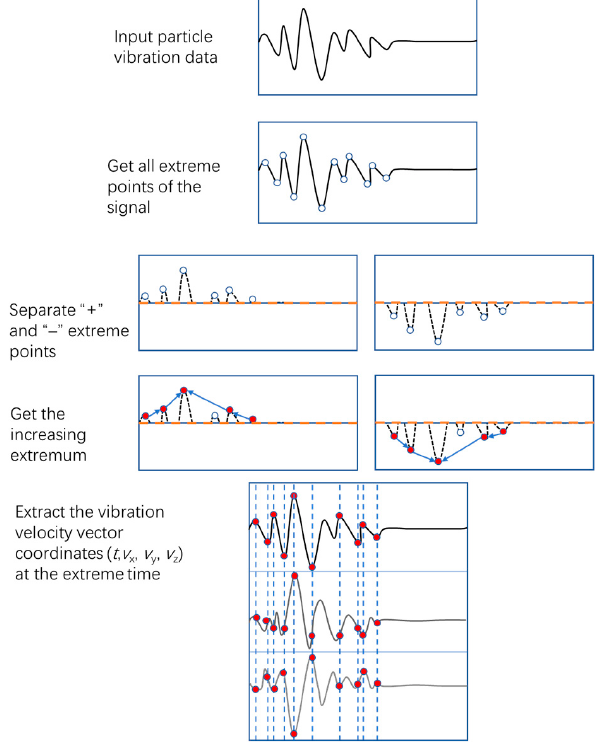
Figure 3. Process of point acquisition of extreme values of increasing particle velocity.